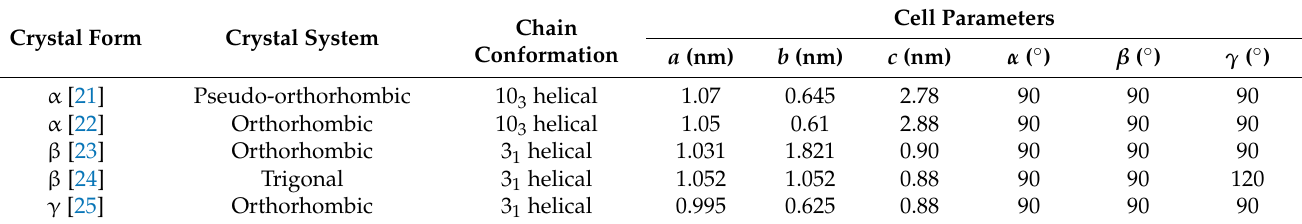
Table 1. Properties of different PLA crystal